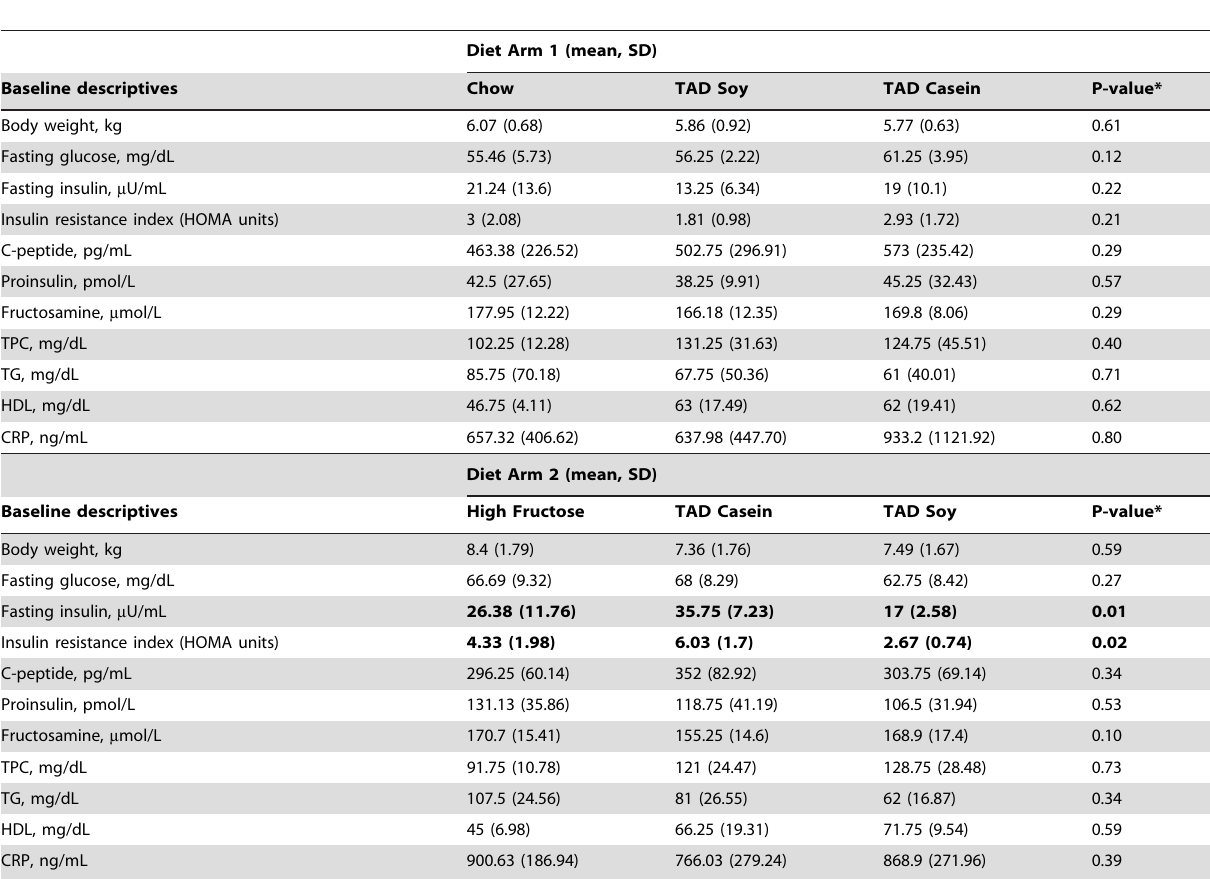
Table 1. Characteristics of monkeys on each diet at baseline and after diet